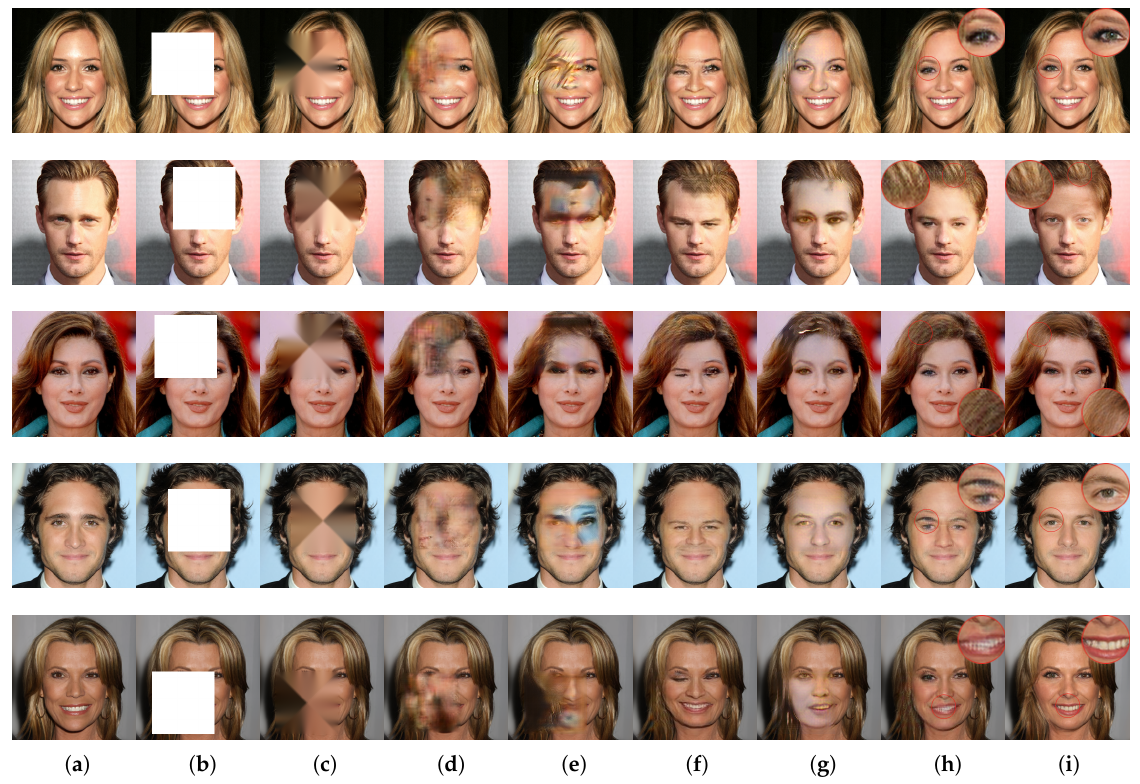
Figure 6. Comparison of qualitative results with the existing methods on random regular masked CelebA-HQ. ( a ) ground truth images; ( b ) masked input images; ( c ) results of the FMM [31]; ( d ) results of the Globally-Locally [19]; ( e ) results of the DeepFill [36]; ( f ) results of the DFNet [38]; ( g ) results of the GMCNN [37]; ( h ) results of the EdgeConnect [23]; ( i ) results of the proposed method PIC-EC, best viewed with